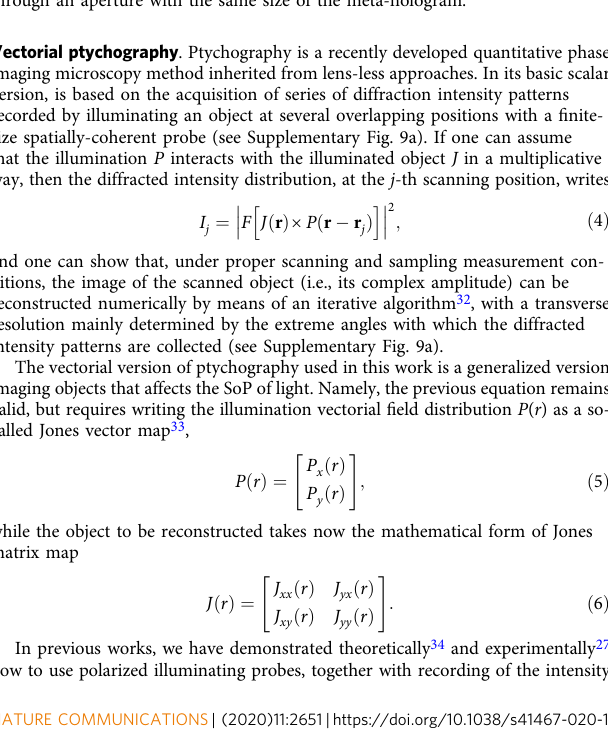
Fig. 5 Polarization characterization of the meta-hologram. a Polarimeter position at different letters to analyze the SoP. b Measured SoP of the corresponding letters. The red and blue dots indicate the designed and measured polarization, respectively. c A linear polarizer with θ LP = 45° and θ LP = 90° are put before letter “ C ” and “ N ” , respectively. A quarter waveplate with θ λ /4 = 0° and a linear polarizer with θ LP = 45° are put before letter “ R ” . A quarter waveplate with θ λ /4 = 112.5° and a linear polarizer with θ LP = 86° are put before letter “ S ” . d Photographs of the holographic images indicate that the four letters are blocked correspondently after placing selected polarizer and quarter through the selected quarter waveplate and linear polarizer, the output electric fi eld E out is described as E out ¼ A LP θ LP ð Þ A λ = 4 ð θ λ = 4 Þ E in . Selected rotation angle θ λ /4 and fi c output images (i.e., E = 0 ). θ out LP are chosen to block the speci Measurement of ef fi ciency . The ef fi ciency of the holographic image was de fi ned as the ratio of the total power of the image at the interested order to the incident power. The power of the holographic image was measured by a power meter (Newport: Model 843-R). The incident power was measured as light passing through an aperture with the same size of the meta-hologram.